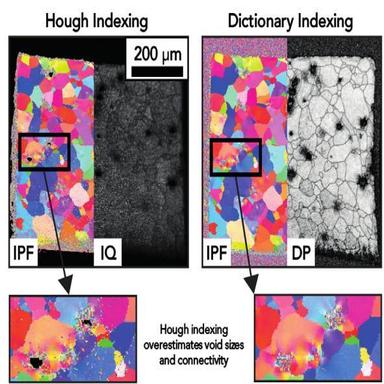
A depiction of the difference between conventional Hough transform-based indexing with the advanced dictionary indexing on a slice of the shockloaded dataset. The left side of each photo depicts the IPF color with respect to the loading direction, while the right side depicts image quality metric (IQ) and the dictionary dot product (DP), respectively. Note that the brightness and contrast on the IQ image has been increased for visual clarity.